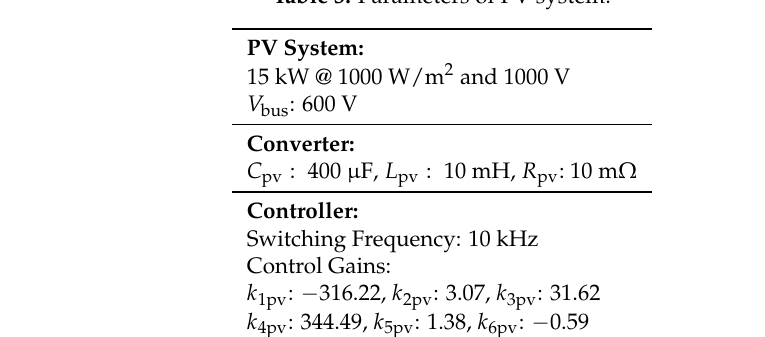
Figure 10. PV converter system and its control. Table 3. Parameters of PV